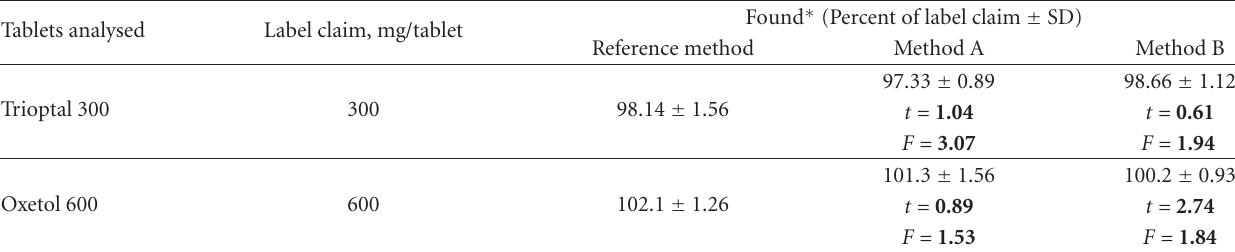
Table 4: Results of analysis of tablets by the proposed methods.